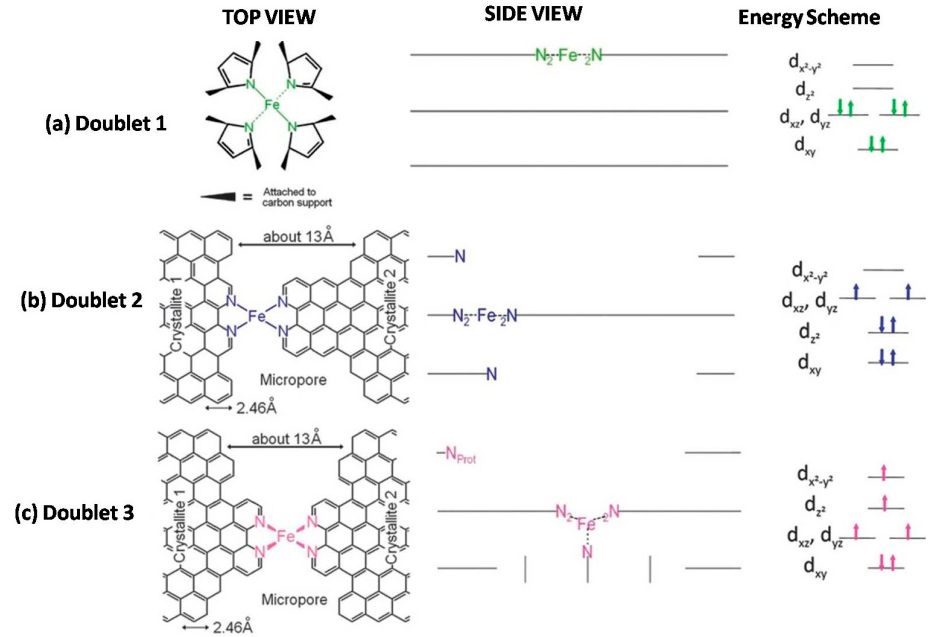
Figure 7. Side views and top views of the proposed structures of: ( a ) the FeN 4 /C catalytic site in heat-treated, macrocycle-based catalysts assigned to Mossbauer doublet D1; ( b ) the FeN 2+2 -like micropore-hosted site found in the catalyst prepared with iron acetate and heat-treated in ammonia assigned to doublet D2; and ( c ) the N–FeN 2+2 -like composite site, where N–FeN 2+2 is assigned to doublet D3. In all side views, graphene planes are drawn as lines. (Reproduce with permission from Ref. [44]. Copyright © Royal Society of Chemistry, London, UK,